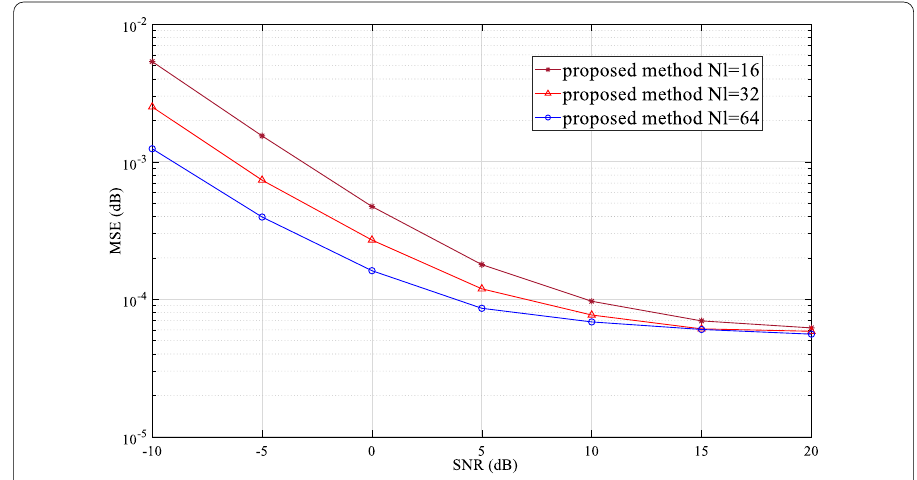
Fig. 5 Comparison MSE performances of the proposed method with L Illustrates the MSE performance as a function of SNR for the proposed methods with lengths of pilot sequences L 16, L 32, and L 64, respectively = = =